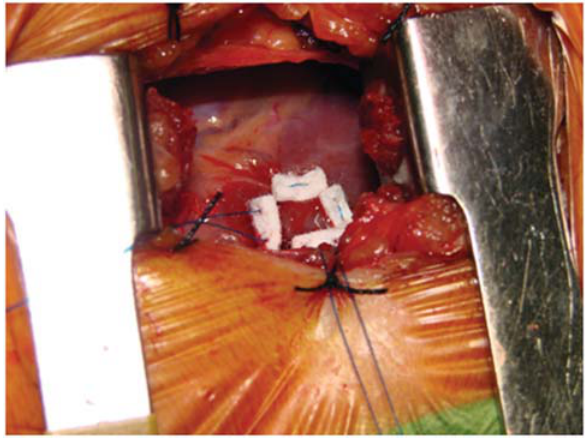
Fig. 4 - Aortografia de controle demonstrando perviedade